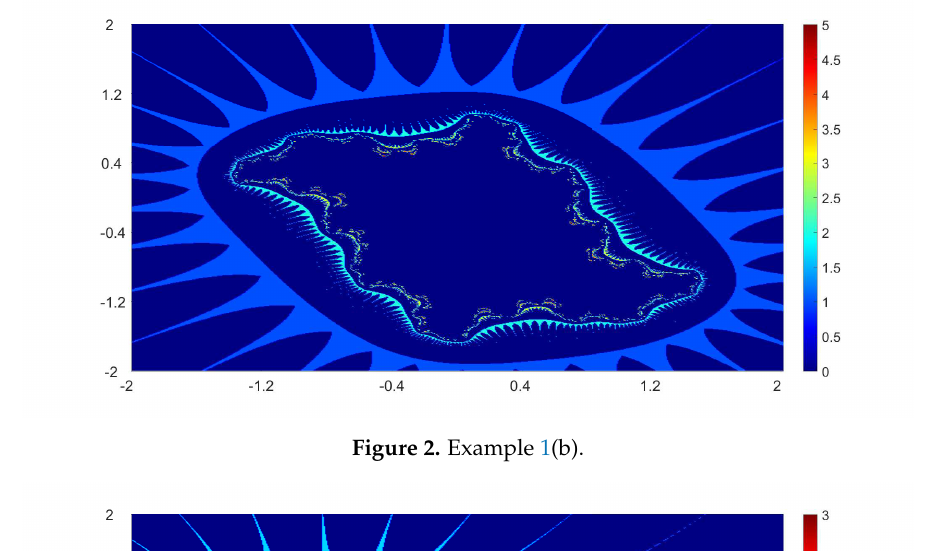
Figure 2. Example 1(b).